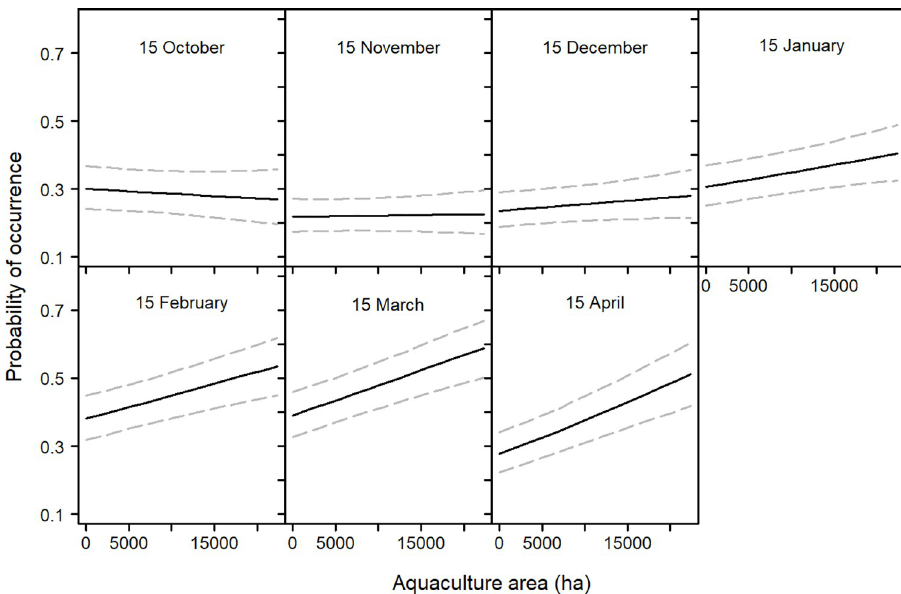
Fig 3. Predicted occurrence probability (+ 95% CI) of cormorants at roosting sites in the Mississippi Delta in relation to an interaction term of aquaculture area within a 23.4 km buffer and date. Trend lines were created from model predictions made by allowing each variable of interest to vary over its range and holding all other variables at their